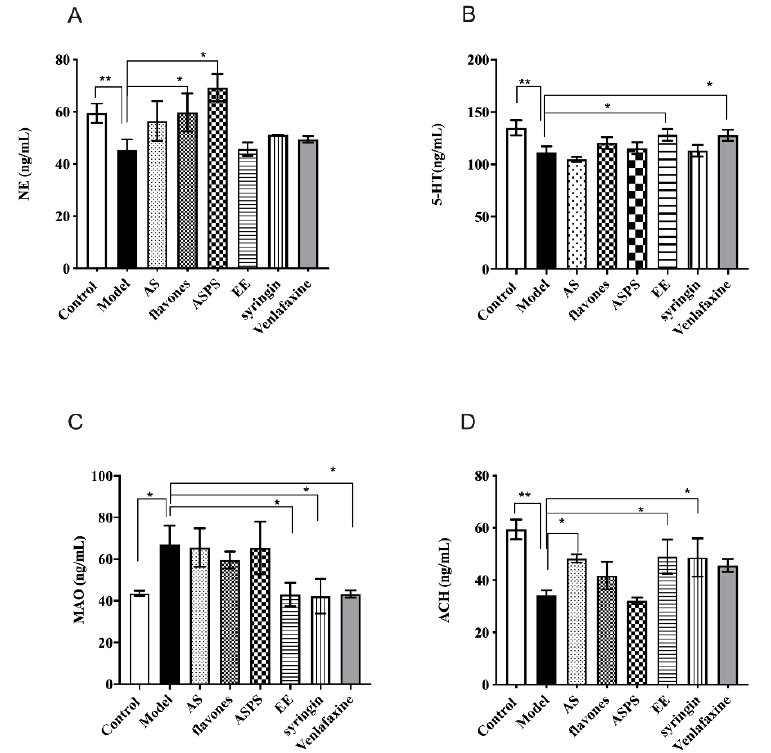
Figure 4. The level of neurotransmitters in brain of each group. (* p < 0.05, ** p < 0.01, n = 5). ( A ) The level of NE in the brains of mice; ( B ) the level of 5-HT in the brains of mice; ( C ) the level of MAO in the brain of mice; ( D ) the level of ACH in brain of mice. (* p < 0.05, ** p < 0.01, n = 5, significant differences between the groups were tested by one-way analysis of variance.)